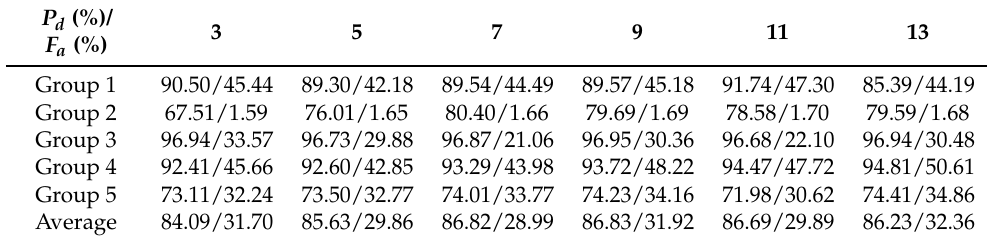
Table 2. Probability and false alarm rate of segmentation results obtained by different dimensional features.